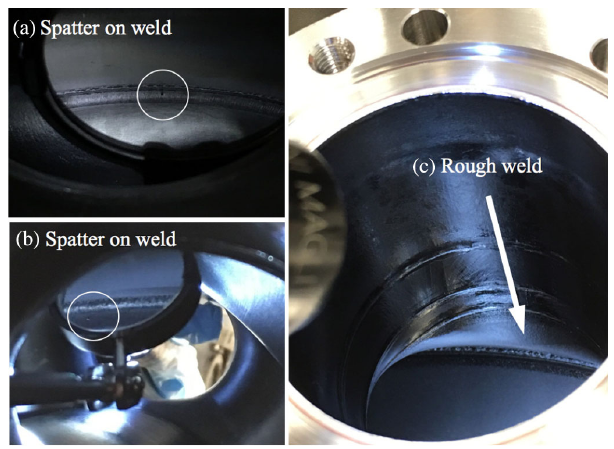
FIG. 14. Surface features in cavity 2 before bulk BCP. Electric and magnetic fields on the weld area are, respectively, 2 MV = m and 65 mT maximum, at 5.3 MV deflecting voltage.